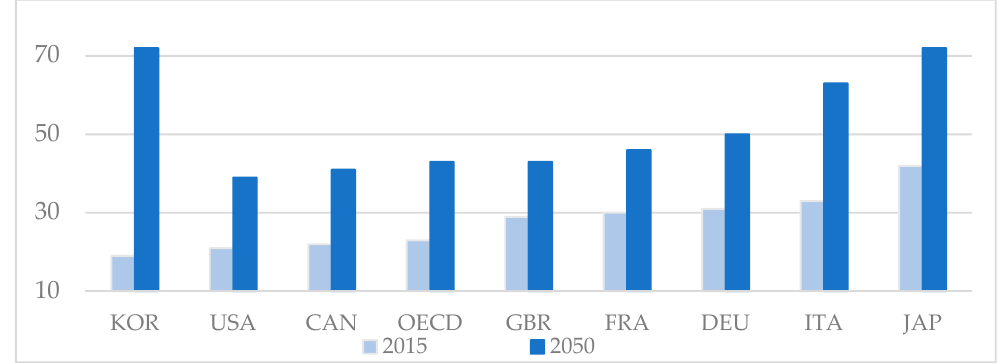
Figure 1. Aging rates of the Organization for Economic Cooperation and Development (OECD) countries [2].